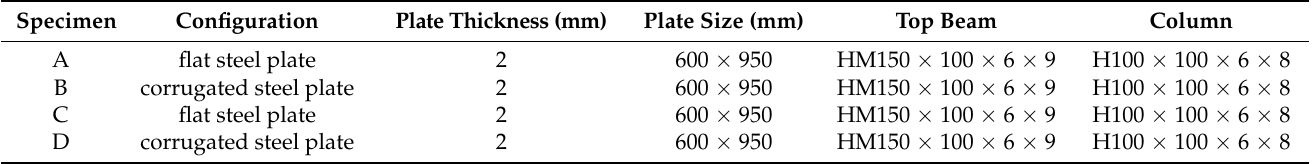
Table 1. Parameters of the steel plate shear wall.